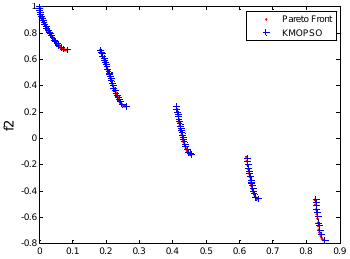
Fig. 13. Pareto fronts produced by KMOPSO for